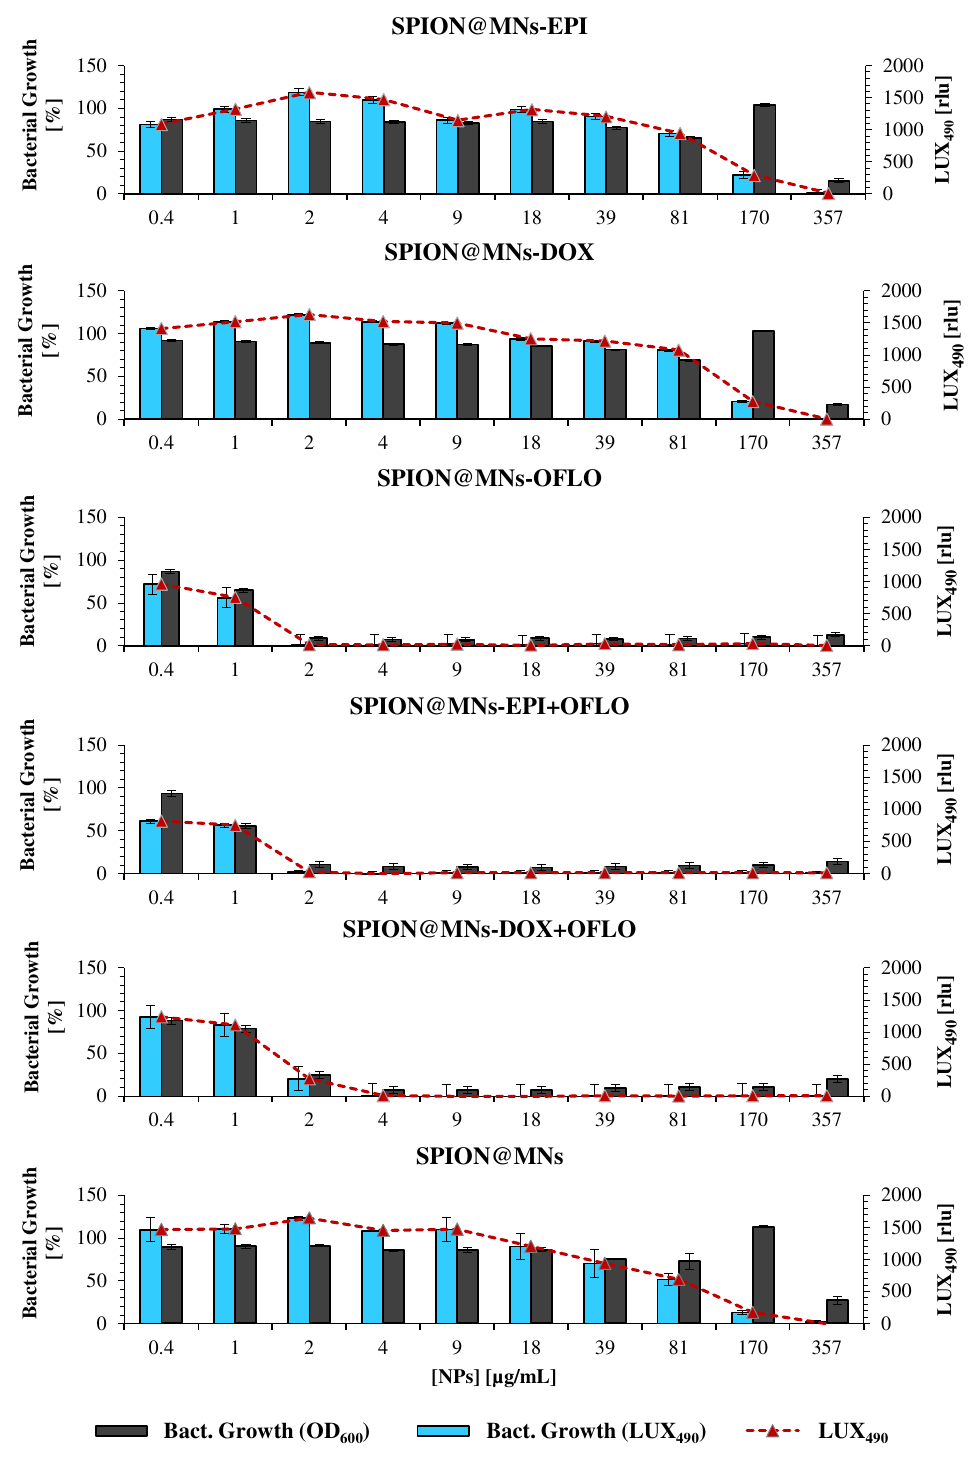
Figure 9. Antimicrobial activity of drug-loaded SPION@MNs on the mutant E. coli Lux strain, measured as bacterial growth calculated by OD 600 and LUX 490 , for 8 h assay; raw LUX 490 signal alone is depicted by the red dotted line and follows the same trend as the calculated bacterial growth.